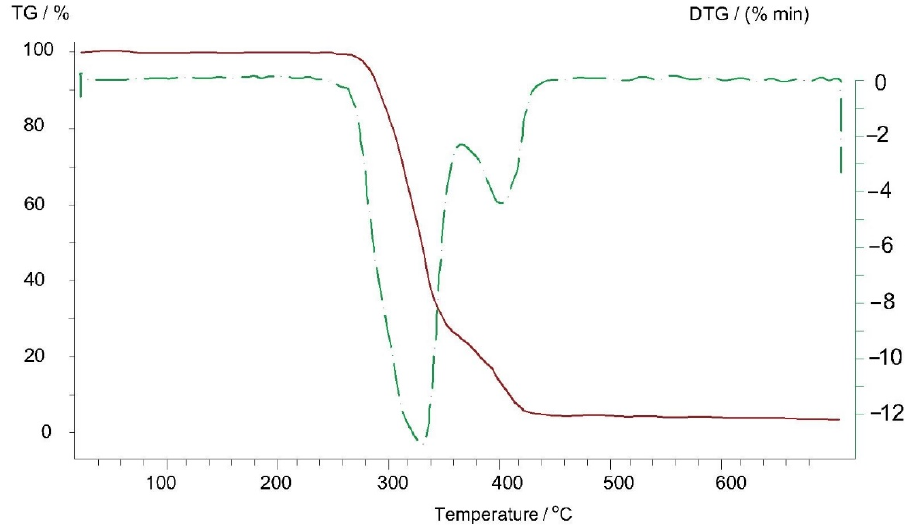
Figure 12. Thermogravimetric curve of the Arboform ® LV3 Nature reinforced with aramid fibers sample.